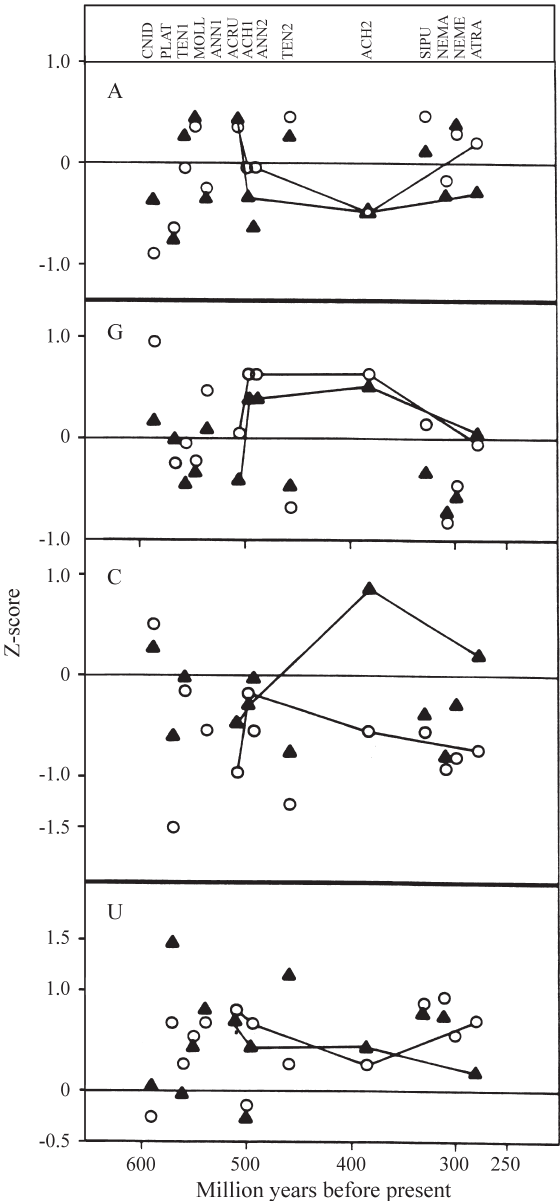
Figure 2 - Frequency of bases and dinucleotides in the 5S rRNA of protostomes vs. paleontologydating.Totalofabase( ∆ );dinucleotides(O) and z-scores calculated as in Material and Methods. The ARTHropod lin- eage (ACRUstaceans, ACHelicerates [ACH1 = Merostomates, ACH2 = Arachnids], ATRAcheids) is united by lines. CNIDarians, PLATyhel- minths, TENtaculates (TEN1 = Brachiopods, TEN2 = Bryozoans), MOL- Luscs, ANNelids (ANN1 = Polichaetes, ANN2 = Oligochaetes), SIPUnculid, NEMAthelmiths,